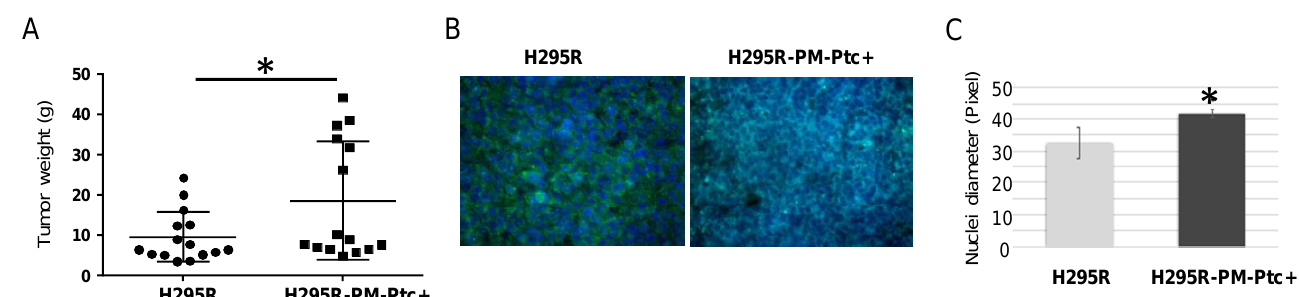
Figure 4. H295R-PM-Ptc+ cells are more tumorigenic than parental cells in mice . Each mouse received a renal subcapsular injection of H295R PM-Ptc+ or parental H295R cells (3 × 10 6 cells; 10 mice for each cell group). After 45 days, mice were sacrificed, tumors were collected, weighed and fixed. ( A ) The mean weight of H295R-PM-Ptc+ tumors is significantly higher than H295R tumors ( n = 9; *: p -value < 0.05 ( p = 0.018)). ( B ) KI67 immunostaining on tumor slices. KI67 is marked with anti-human KI67 antibody recognized with a secondary antibody coupled to Alexa 488 (green staining) and DAPI (blue staining). Images were taken with an epifluorescence microscope (40 × ). ( C ) Tumors derived from H295R-PM-Ptc+ cells present bigger nuclei compared to tumors from parental cells. For each tumor, 20 nuclei diameters were measured (SRC-sample randomly chosen) from slides using imageJ software. Six H295R tumors and seven H295R PM-PTC+ tumors (*: p -value < 0.005). Tumorigenesis and metastases were then addressed in ovo. This system consists of the injection of H295R-PM-Ptc+ cells or parental H295R cells at the chorioallantoic mem- brane (CAM) of two groups of fertilized white leghorn eggs at day 9 of embryonic devel- opment (E9). At day 18 of embryonic development (E18), tumors and embryos were col- lected and analyzed (Figure 5A). The tumors originated from H295R-PM-Ptc+ were sig- nificantly bigger than H295R tumors, confirming the results obtained in mice (Figure 5B). Metastasis quantification was addressed using real time qPCR with human ALU se- organs. As ACC cells have a hepatic tropism, genomic DNA was extracted from the livers of the embryos. Real time qPCR revealed that there were more metastases in the livers of embryos from eggs injected with H295R-PM-Ptc+ compared to those from eggs injected with parental H295R cells (Figure 5C).